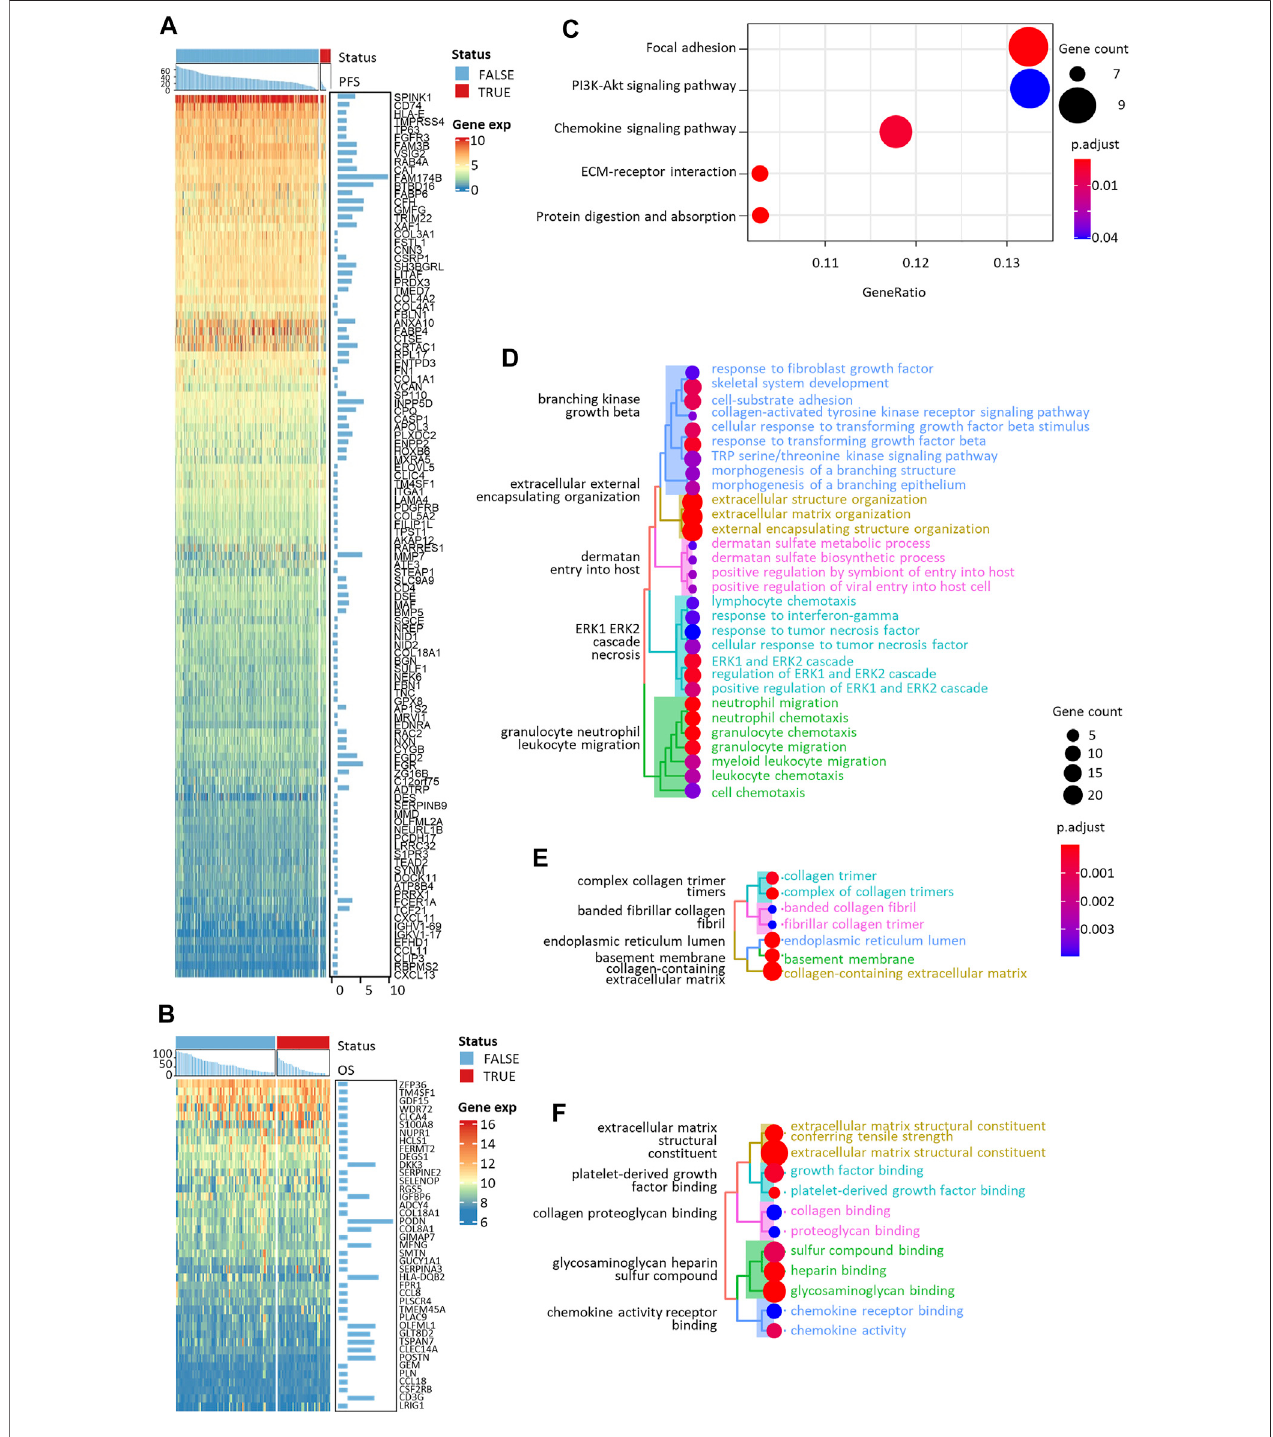
FIGURE3| ExpressionheatmapsandfunctionalenrichmentanalysesofPFS-andOS-relatedimmunecell-speci fi cDEGs.Expressionheatmapsof (A) PFS-related and (B) OS-related DEGs. KEGG (C) , GO-biological process (D) , GO-cellular component (E) , and GO-molecular function (F) enrichment of all the selected DEGs.